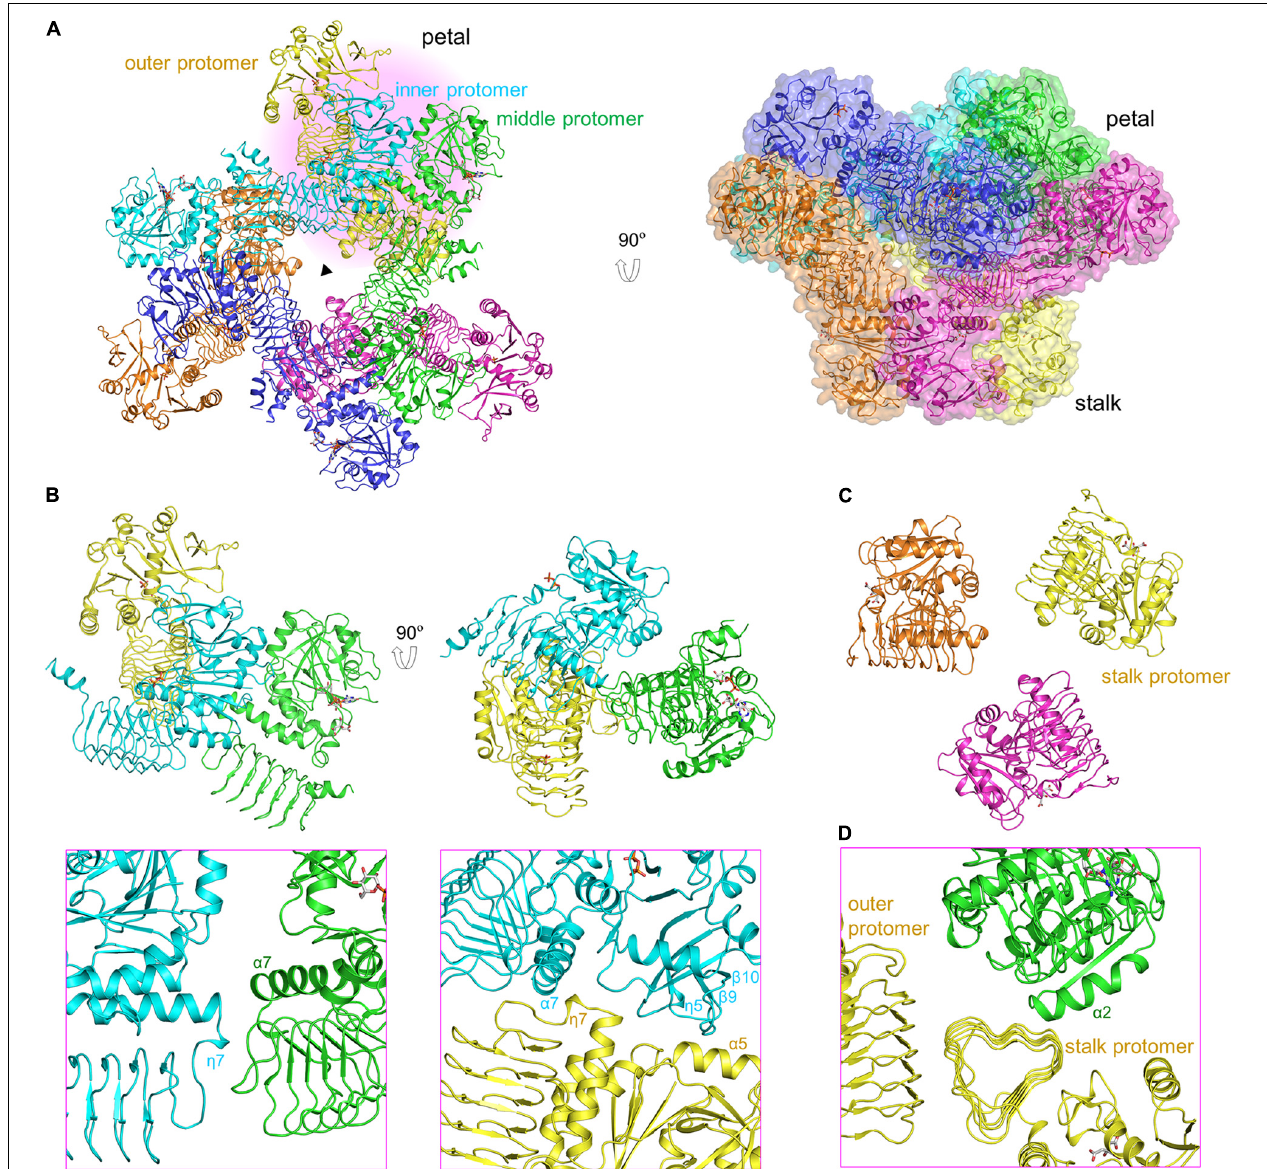
FIGURE 3 | Dodecameric structure of product-bound VTC1. (A) Overall structure of dodecamer. Six dimers are colored in green, blue, cyan, yellow, brown, and magenta, respectively. GDP-Man, PPi and citrate are in stick representation. The three-fold symmetry center is denoted by a triangle. The petal on a light pink background is shown in (B,D) . A transparent surface of the dodecamer is shown in the right panel. (B) The inner, middle, and outer protomers. Upper left panel is the enlarged view of the petal. Two interfaces contributing to trimerization are enlarged and shown in the lower panels (pink boxes), where only two interacting protomers are shown for clarity and the orientations differ from those in upper panels to delimitate the interfaces. (C) Three stalk protomers. The image is the enlarged view of the stalk shown in the left panel in (A) . (D) The stalk-petal